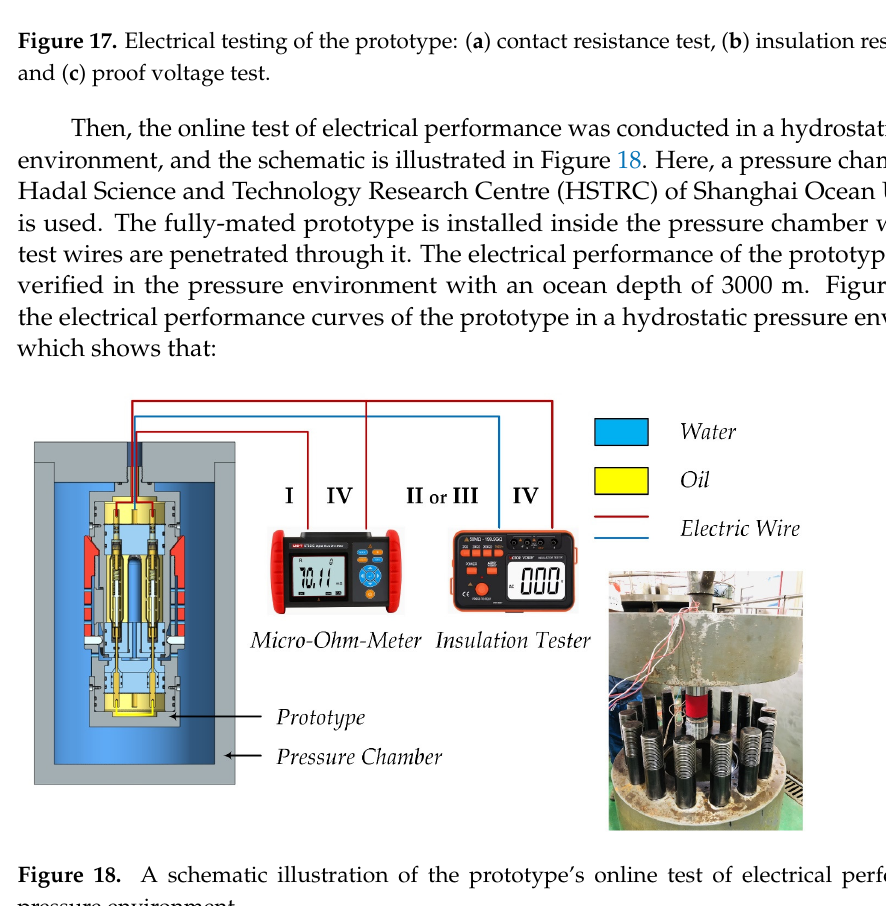
Figure 19. The electrical performance curves of the prototype in a hydrostatic pressure environment: ( a ) contact resistance and ( b ) insulation resistance. 4.3. Failure Analysis The above tests also revealed the failure modes of wet-mateable electrical connectors, which are discussed as follows: (1) The main failure mode of wet-mateable connectors is sealing failure [23]. For the proposed connector, because the dual-bladder PBOF technology is introduced, only the common O-ring is used in the shuttle pin design. Additionally, its small size limits the sealing pressure of the penetrable self-sealing. (2) Another important failure mode is the PBOF failure. Some ultimate pressure tests were conducted on the prototype. Under the condition with a very large pressure rate (about 10 MPa/min), the destruction of the primary resilient bladder was observed. As is shown in Figure 20, a very clean cut appears on the primary bladder. The PBOF failure can lead to the rapid loss of the sealing performance, which must be avoided. According to the failure analysis, we can realize how to improve the depth rate of the prototype in the future, and two aspects should be focussed on as follows: (1) Replace the rod seals in the shuttle pin design to improve the sealing performance of the penetrable seal-sealing. For example, O-rings made of fluorosilicone rubber with high hardness or other rod seals with high sealing pressure can be used. (2) Woven fabrics can be added to the material of resilient bladders to enhance the strength, which can improve the reliability of PBOF technology.